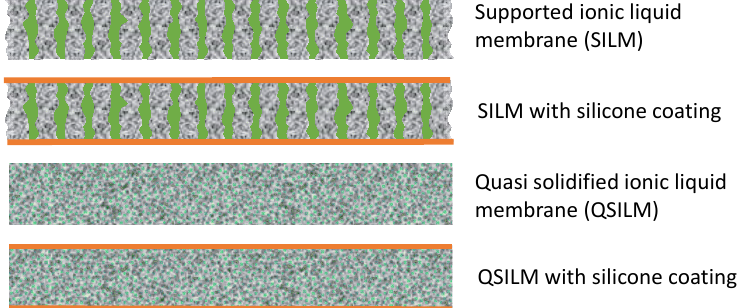
Figure 3. Schematic representation of the possible types of supported ionic liquid membranes. Green = ionic liquid, grey = porous support of gel former, orange = silicone.